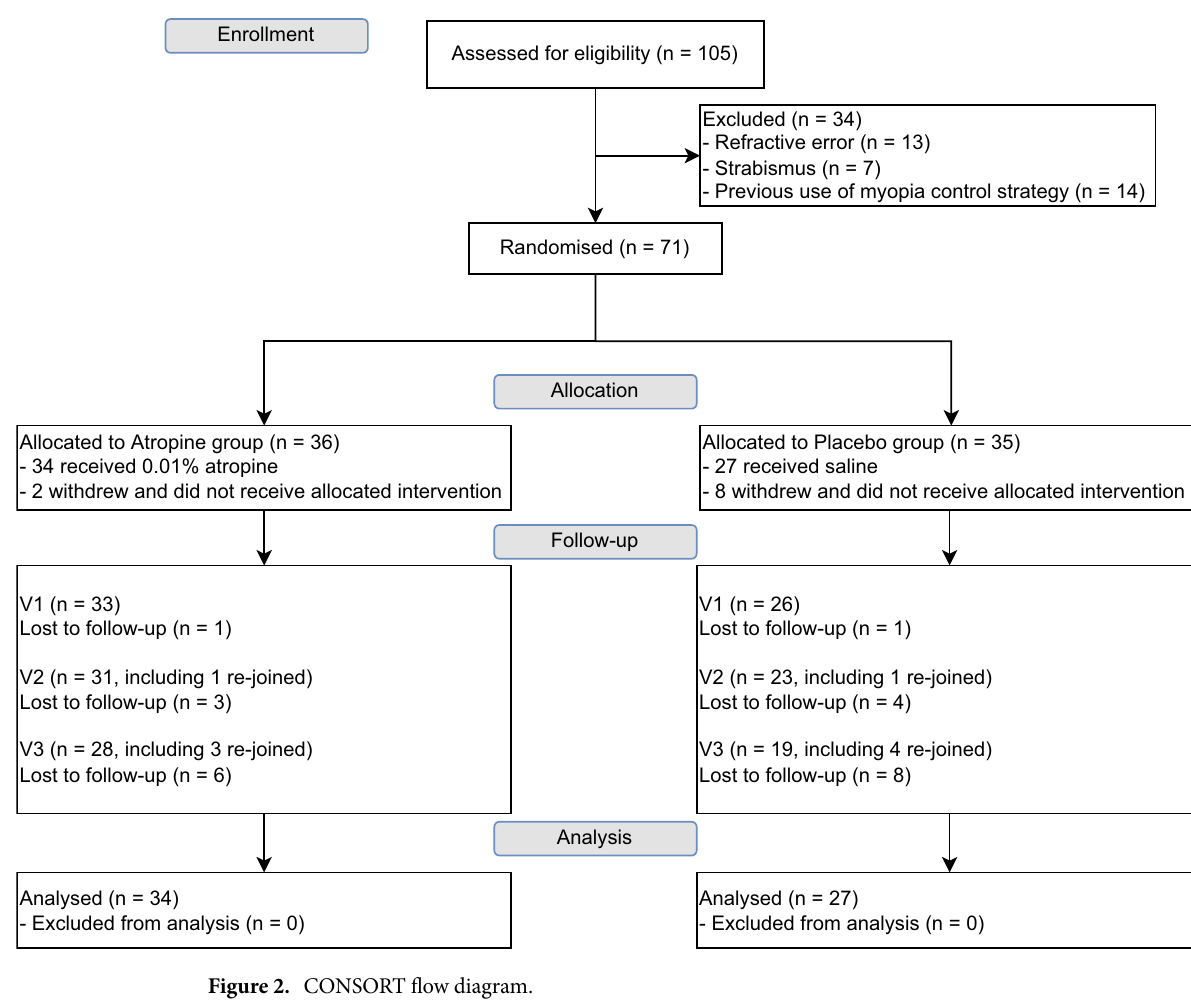
Figure 2. CONSORT flow diagram.